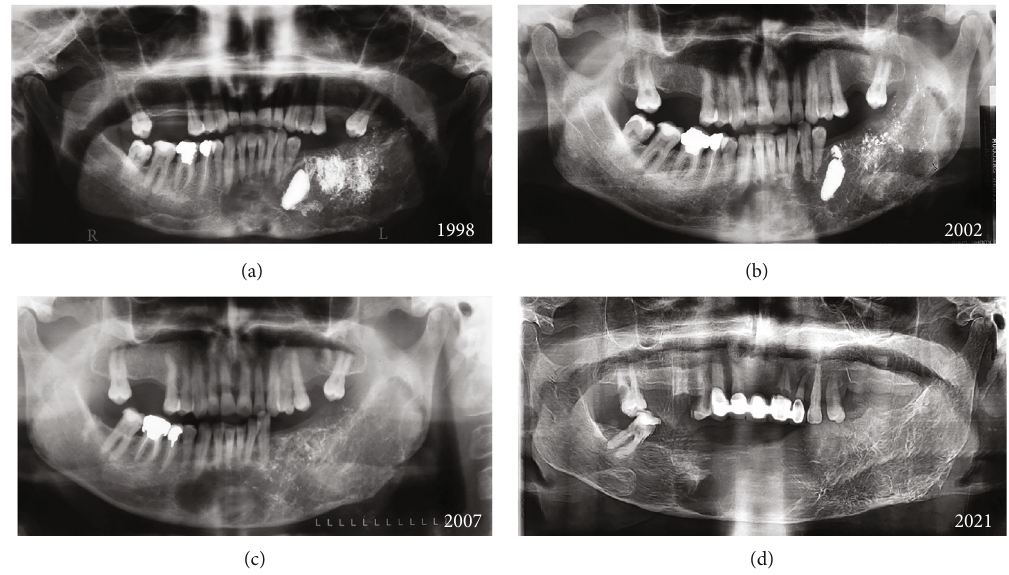
Figure 4: (a) The same day panoramic radiograph. (b) 4-year panoramic radiograph. (c) 9-year panoramic radiograph. (d) 22-year panoramic radiograph; note the calci fi cation inside the lesion.